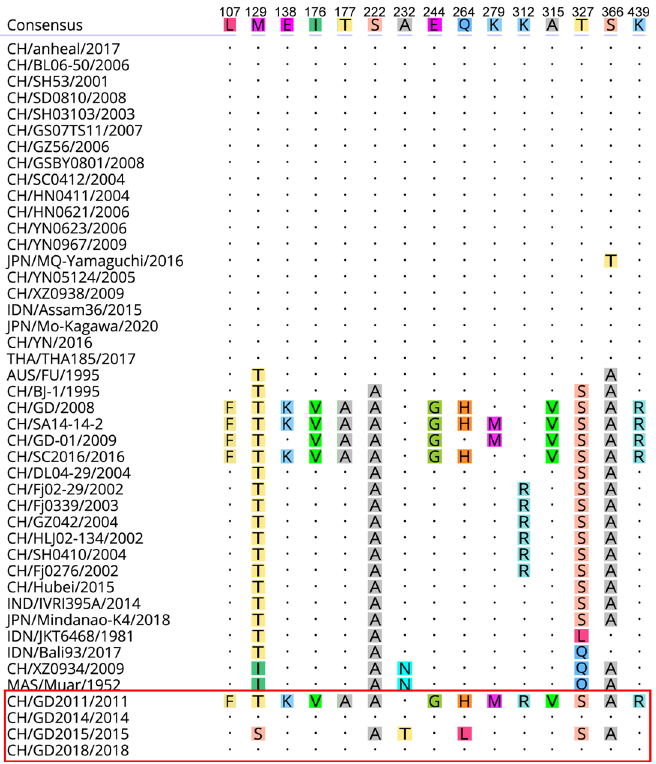
Figure 6. Amino acid mutation analysis of JEV E protein. Different amino acids are marked with different colors, and amino acids with the same position are replaced by “·”. (the isolates of this study are in the red box).